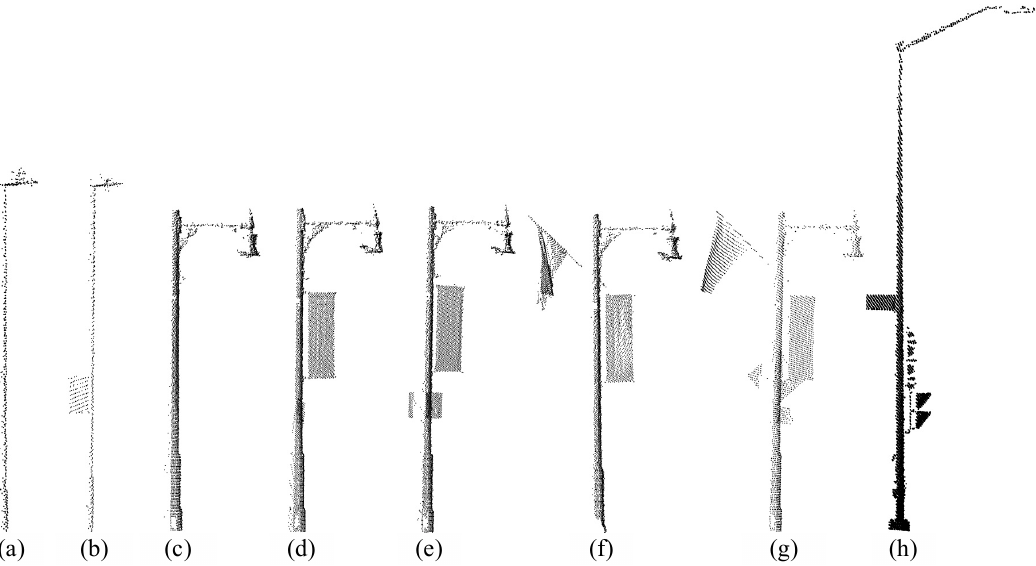
Figure 18. Differently shaped street lamps. ( a ) and ( b ) belong to Data I; ( c ), ( d ), ( d ), ( e ), ( f ), ( g ) and ( h ) belong to Data II.